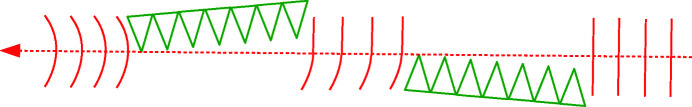
Illustration of wavefronts passing through a longitudinally offset saw-tooth lens pair, operating at slightly different focal lengths to establish convergence to a common focus.